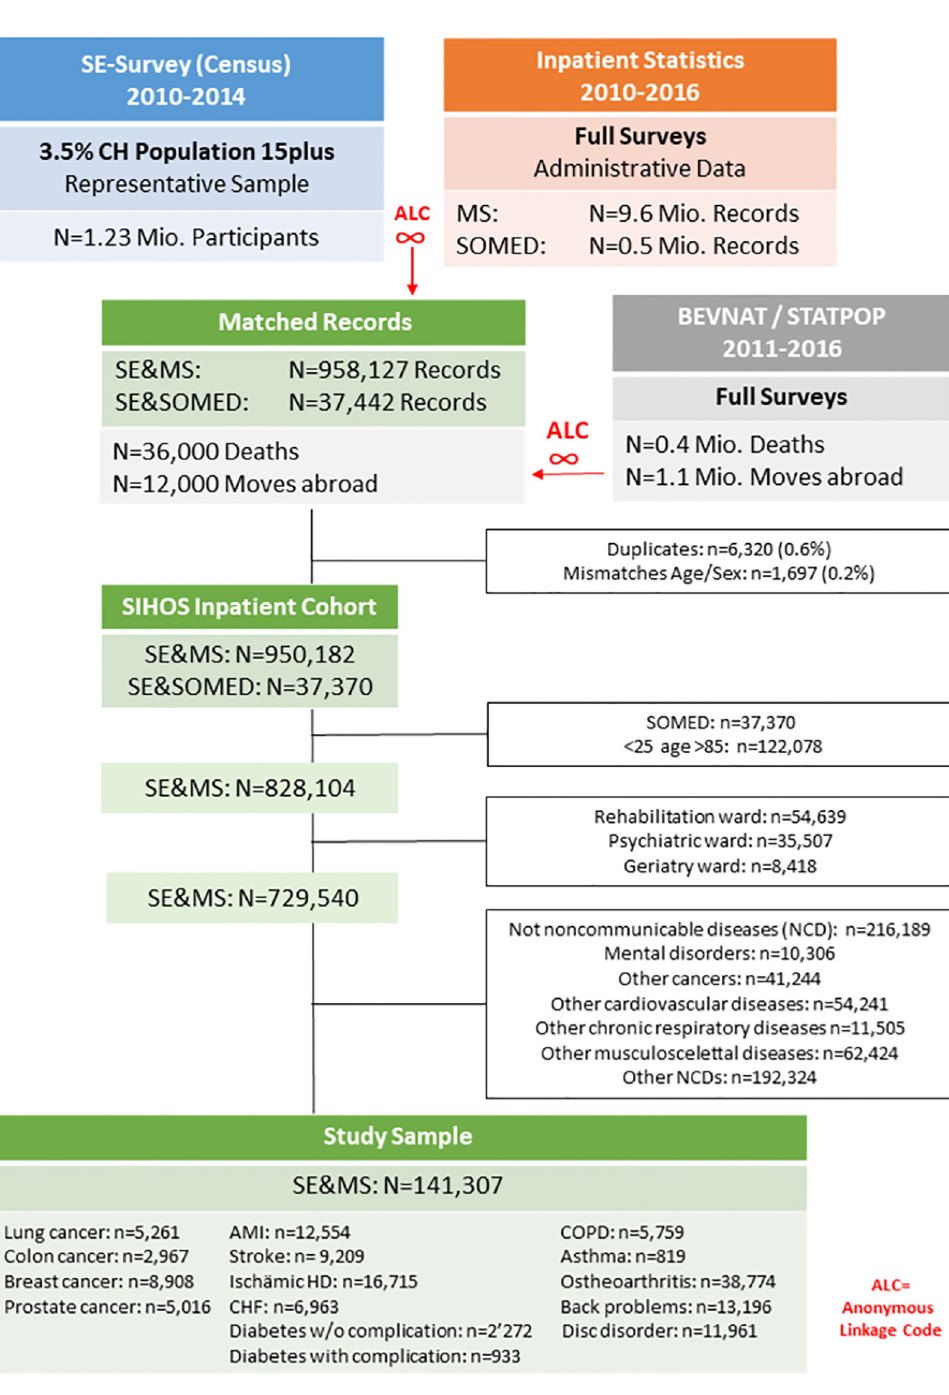
Outcome. Length of hospital stay (LOS) was based on SwissDRG definition, calculated by day of admission and each subsequent day without the day of discharge and excluding days of leave [60].